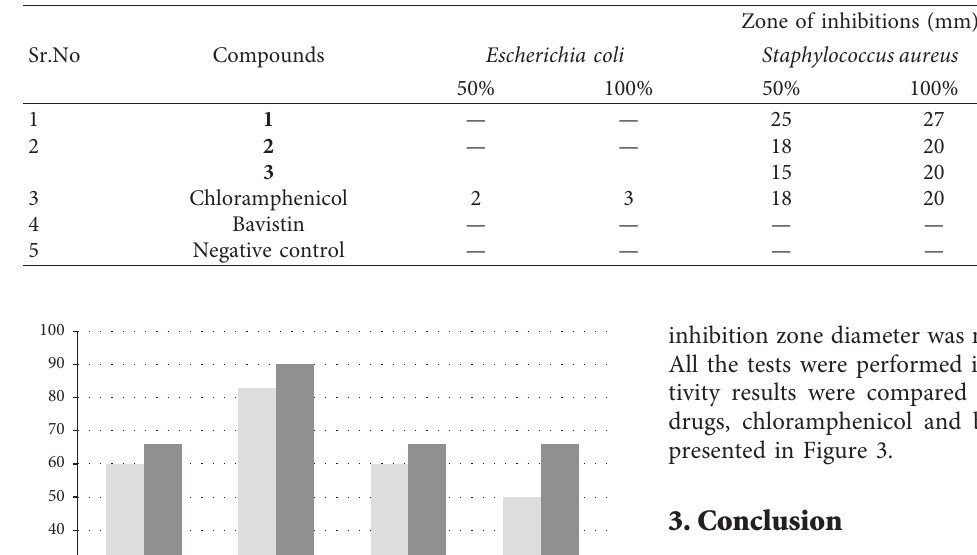
Table 2: Antimicrobial activities of target compound 1–3 .